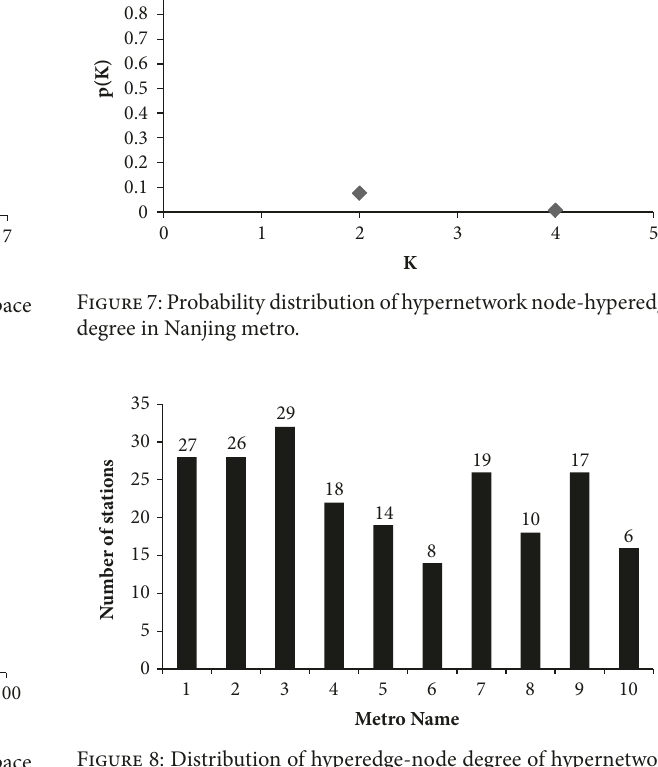
Figure 6: Probability distribution of node degree in Space P space of complex network in Nanjing metro.